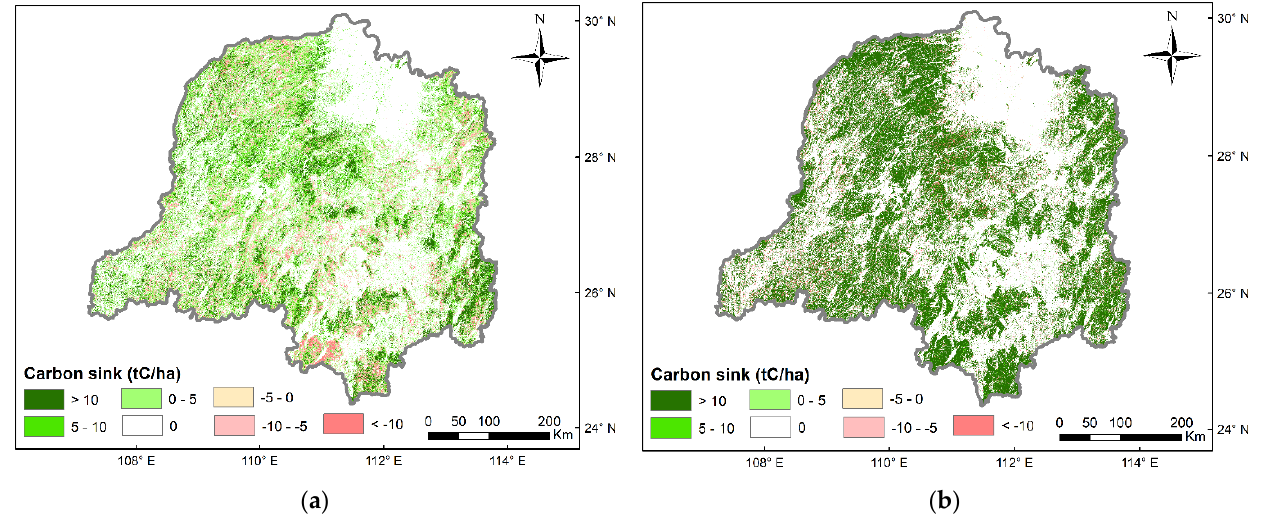
Figure 7. Maps of carbon sinks of forest and shrub from 2000 to 2020. ( a ) Map of carbon sink of forest and shrub between 2000 and 2010; ( b ) map of carbon sink of forest and shrub between 2010 and 2020.